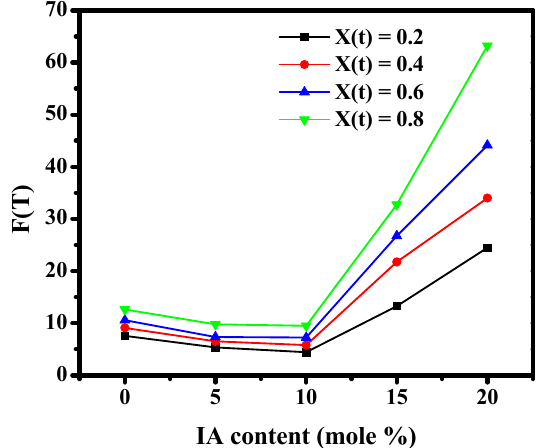
Figure 10. Plots of F( T ) as a function of IA content for PBABI copolyesters at a range of relative crystallinity in 0.2–0.8. IA is itaconic acid.